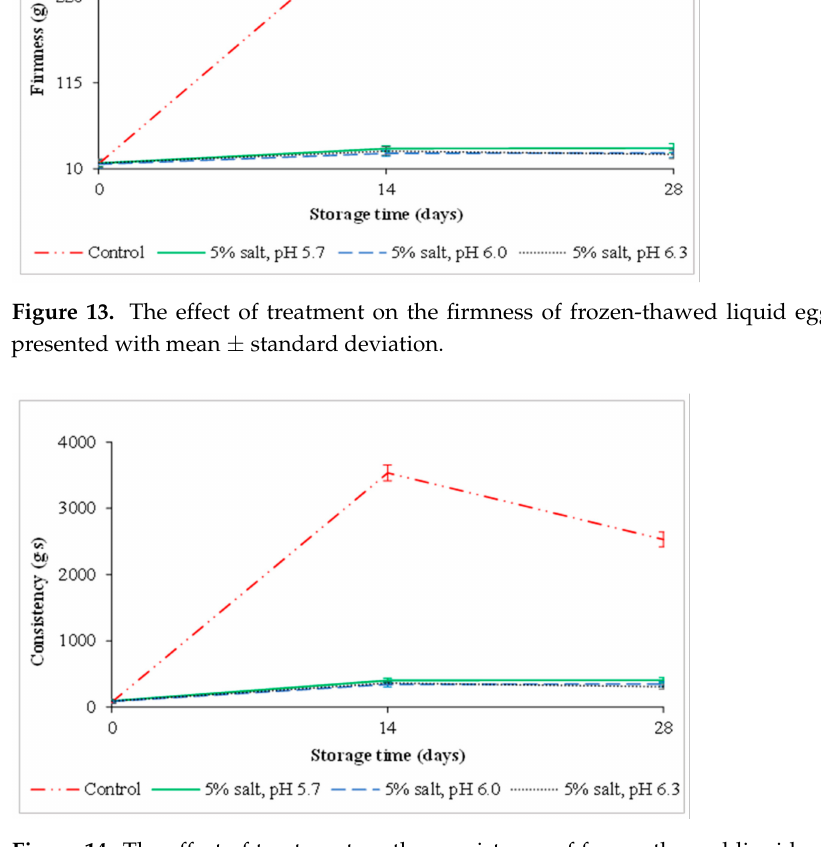
Figure 14. The effect of treatment on the consistency of frozen-thawed liquid egg yolk. Data are presented with mean ± standard